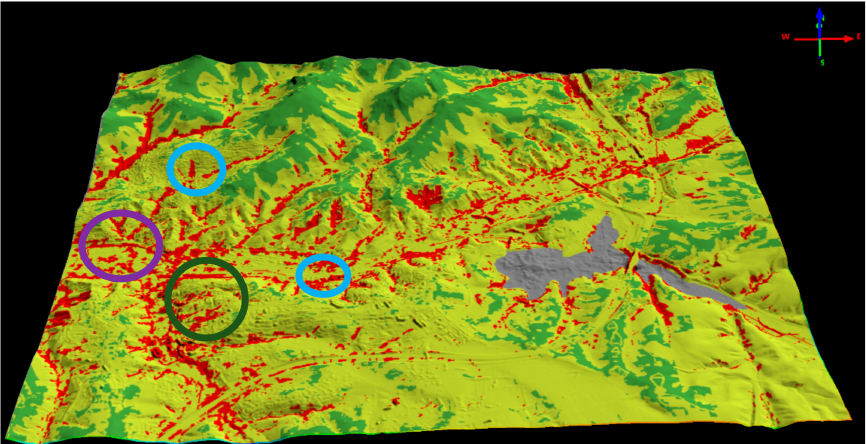
Figure 23. The DTM of the study area textured with the MHSL (multi-hazard susceptibility level) map. The circles denote important focal areas for city planning in northwest and south Mamak as mentioned